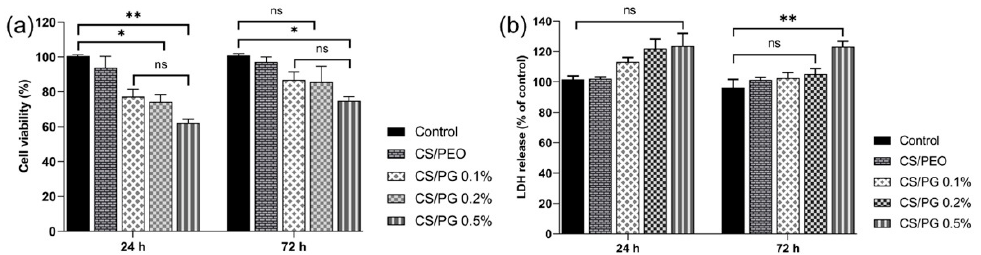
Figure 9. In vitro cytocompatibility of all electrospun scaffolds on fibroblast cells, after 24 and 72 h; ( a ) MTT assay; controls at 24 and 72 h are considered as 100% (ns p < 0.5, * p < 0.05, ** p < 0.005); and ( b ) LDH assay (ns p < 0.1, ** p < 0.01).